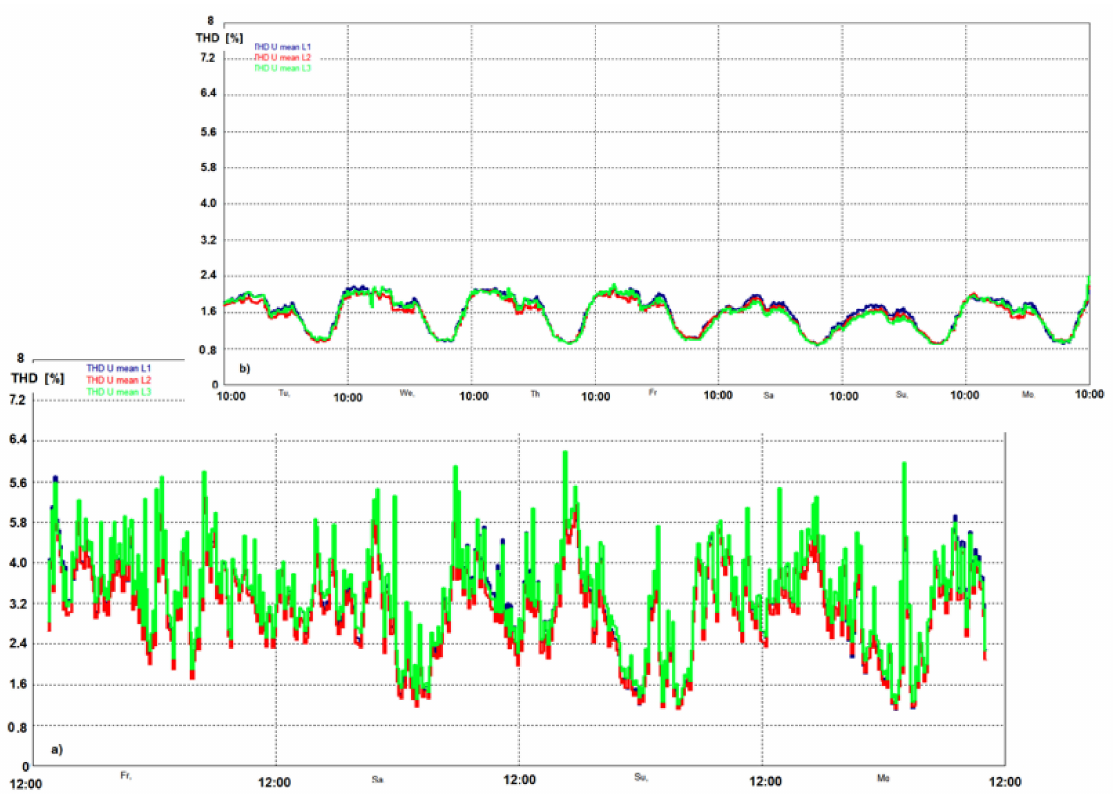
Figure 21. Changes in THDI coefficients measured in point C ( a ) and comparatively in the line supplying municipal consumers ( b ).